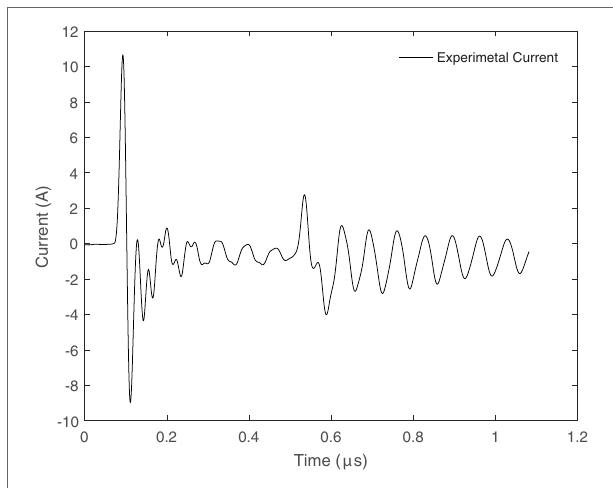
FigUre 6 | Typical output current